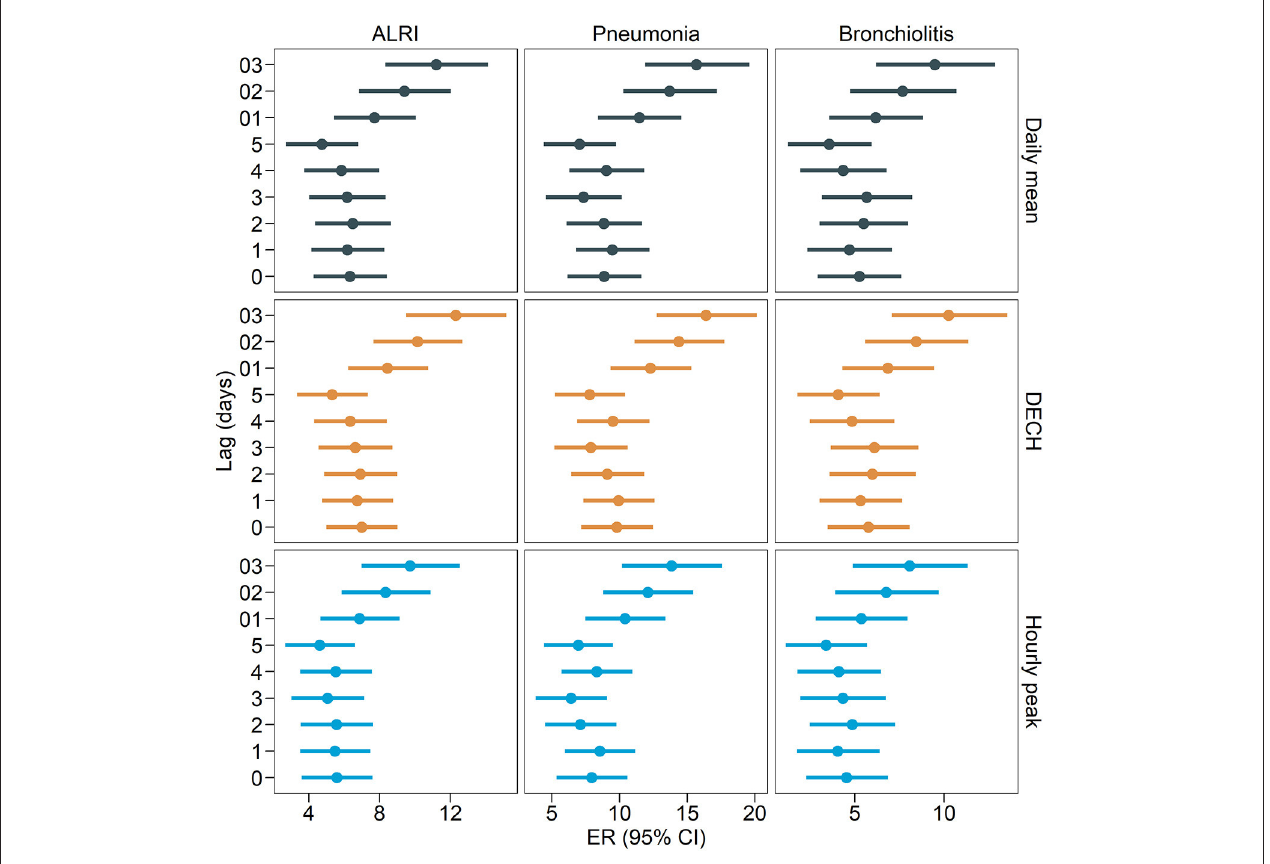
FIGURE 2 | Excess risk (95% confidence intervals) of outpatient visits related to acute lower respiratory infections per interquartile range increment in ambient PM 2.5 (daily mean, daily excessive concentration hours [DECH], and hourly peak) at different lag